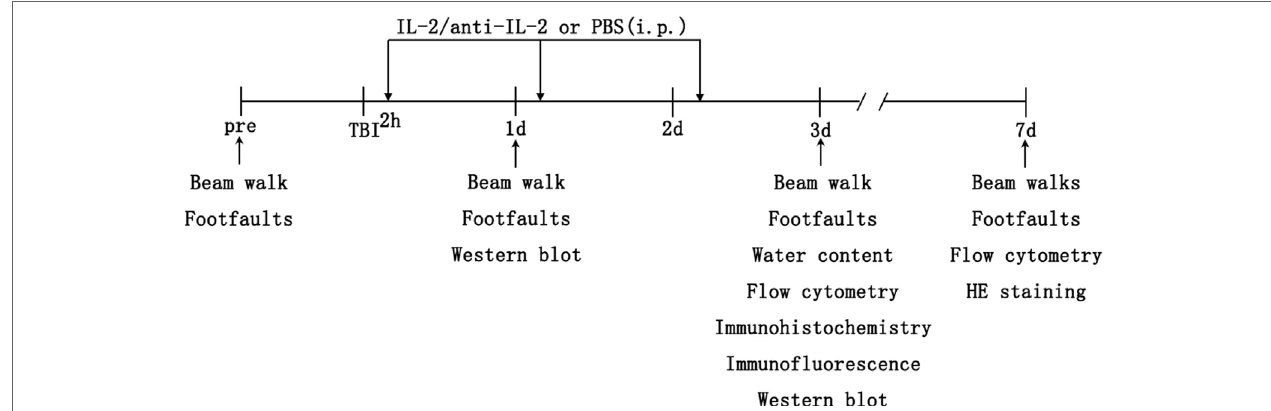
FigUre 1 | Schematic diagram of the experimental design. C57BL/6 mice underwent controlled cortical impact to the right cortex on day 0. Then, the mice received 200 µl intraperitoneal injections of either IL-2C or PBS at 2, 24, and 48 h after traumatic brain injury (TBI). The brains were harvested post-injury for immunohistochemistry/immunofluorescence, flow cytometry, brain water content, and protein analysis. Sham mice were subjected to the same assays without undergoing brain